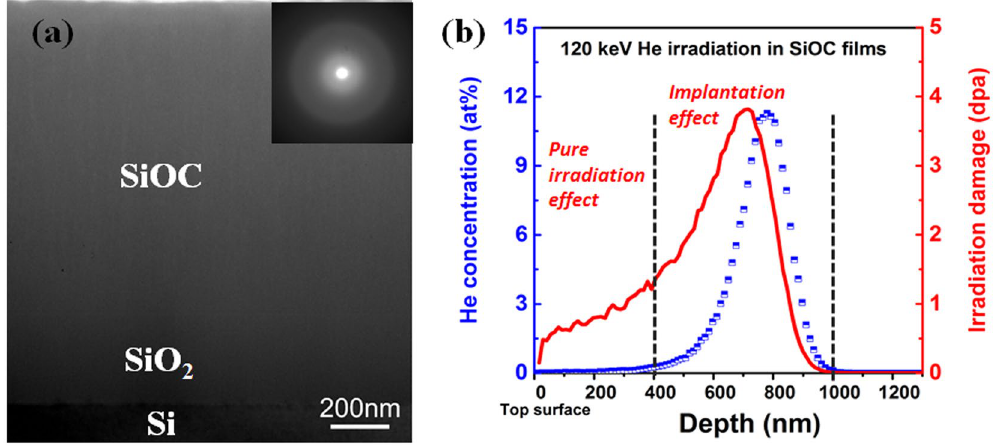
Figure 1. ( a ) Cross-sectional TEM image of as-deposited SiOC film. The inset is the corresponding selective area diffraction pattern. ( b ) Simulated depth profile of helium concentration and irradiation damage for SiOC films after 120 keV He